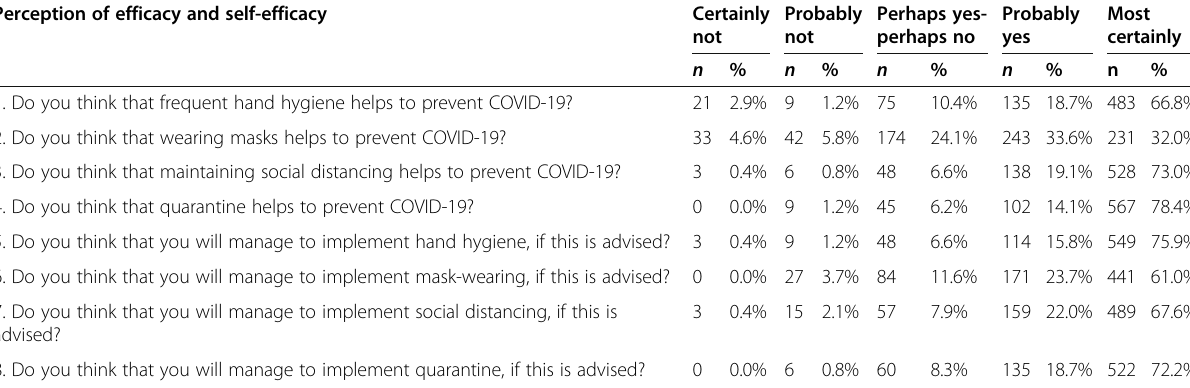
Table 7 Perceptions of efficacy and self-efficacy in dealing with COVID-19 ( N = 723) Perception of efficacy and self-efficacy